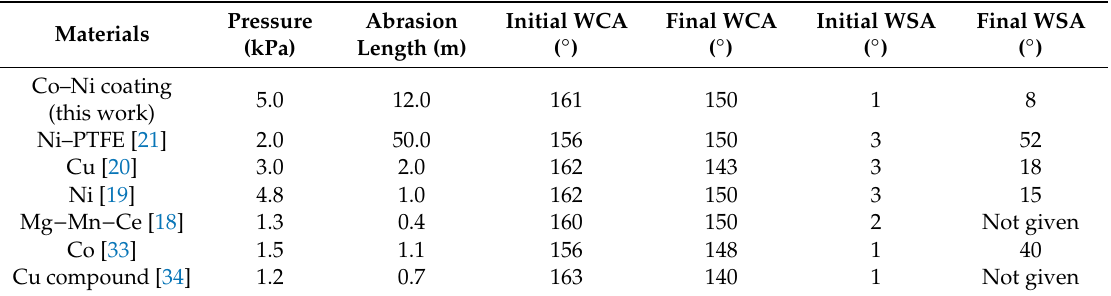
Table 2. Abrasion distances leading to the loss of super-hydrophobic properties. Abrasive medium: 800 grit SiC sandpaper.